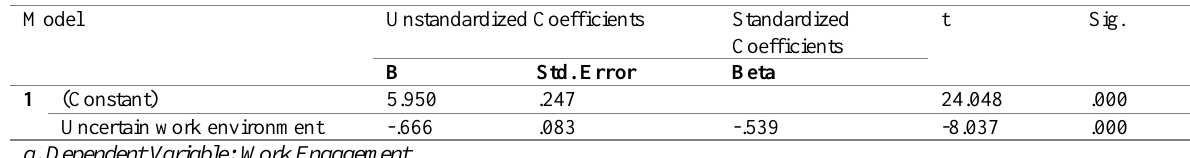
Table 13: Coefficients for uncertain work environment on work